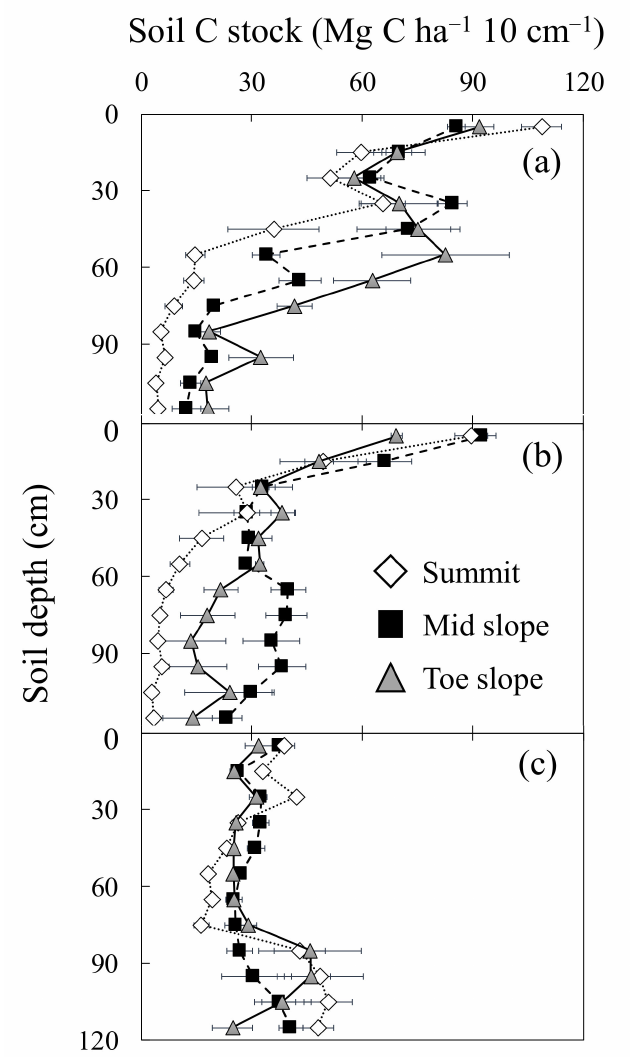
Figure 3. Soil carbon stock at 10 cm increments down to a 1.2 m depth for three positions along catenas at three semi-natural Miscanthus sinensis grassland sites in Japan: Kawatabi Field Science Center, Miyagi Prefecture (KAW) ( a ); Soni Plateau, Nara Prefecture (SONI) ( b ); Aso-Kuju National Park, Kumamoto Prefecture (ASO) ( c ). Error bars represent the standard